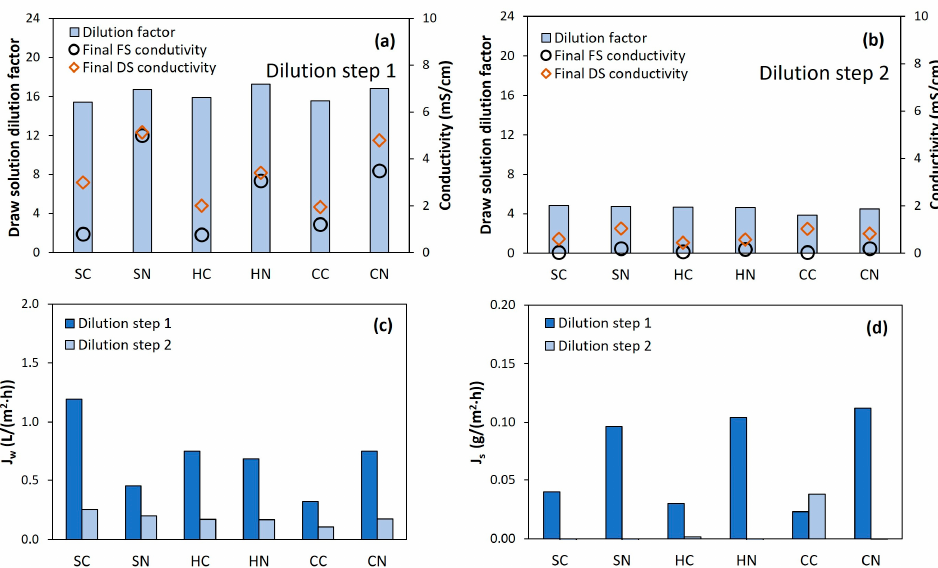
Figure 2. Results for the FO dilution tests. DS dilution factors in step 1 and step 2 of the FO process ( a , b ), water flux through the membrane ( c ) and reverse salt flux through the membrane ( d ). Reference for MgP salts: S, struvite; H, hazenite; C, cattiite. Reference for acids: C, citric acid; N, nitric acid.